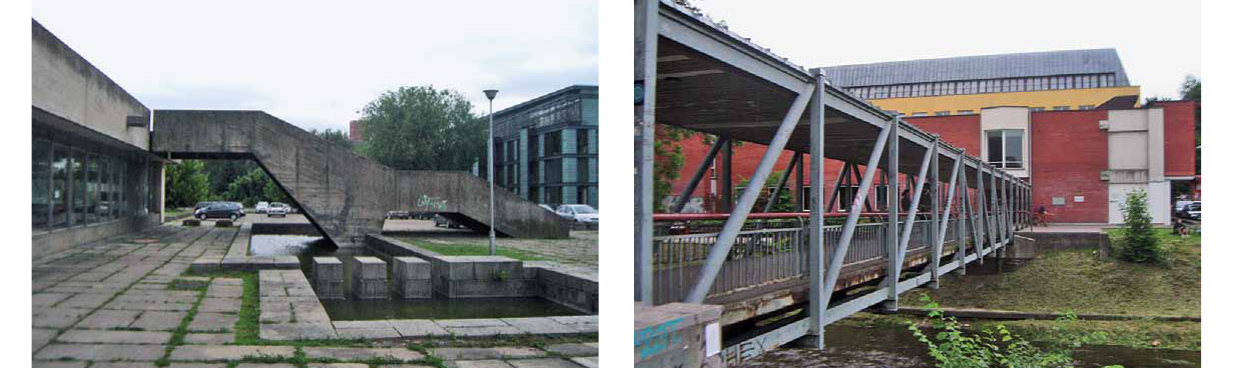
vedančiu į lauko terasą. a. novicko nuotr. Fig. 2. View of the bridge of the Concert and Sports Palace in Vilnius leading to the upper outdoor terrace. a. novickas photo